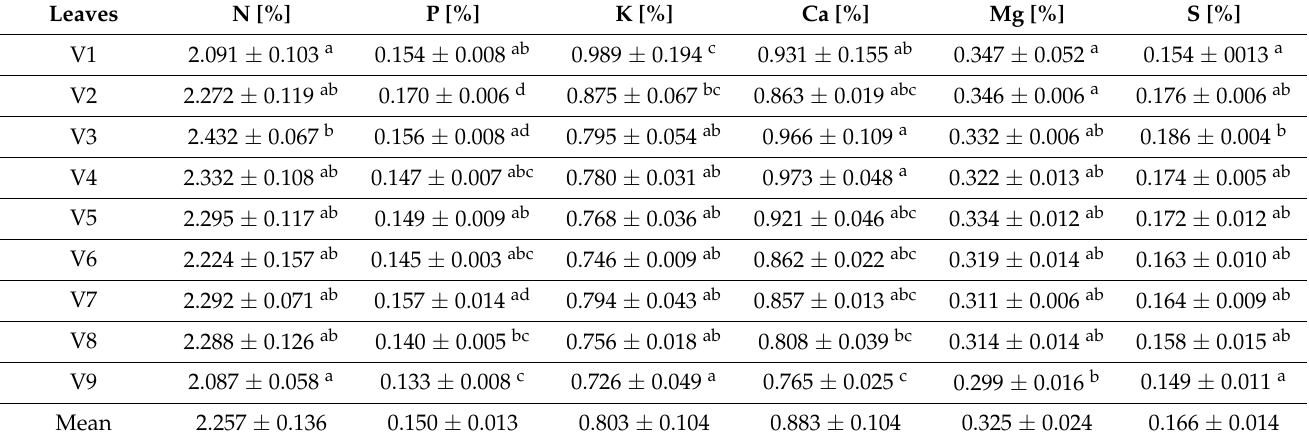
Table 3. Percentages of macroelements in the leaves for each substrate density variant ( ± SD). The letters a, b, c and d indicate significant differences between the